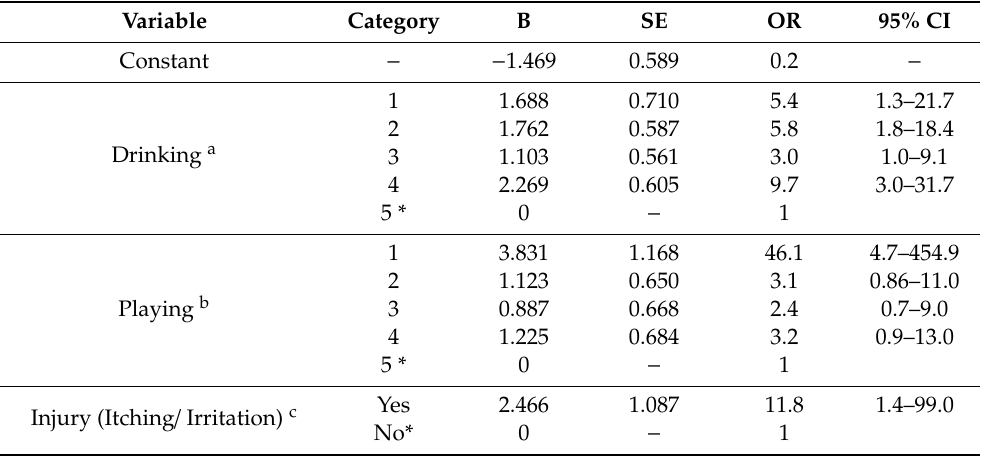
Table 2. Factors identified as being the best predictors of a worse quality of life outcome in an online survey conducted on welfare implications of Elizabethan collar (Elizabethan collar) use in companion dogs and